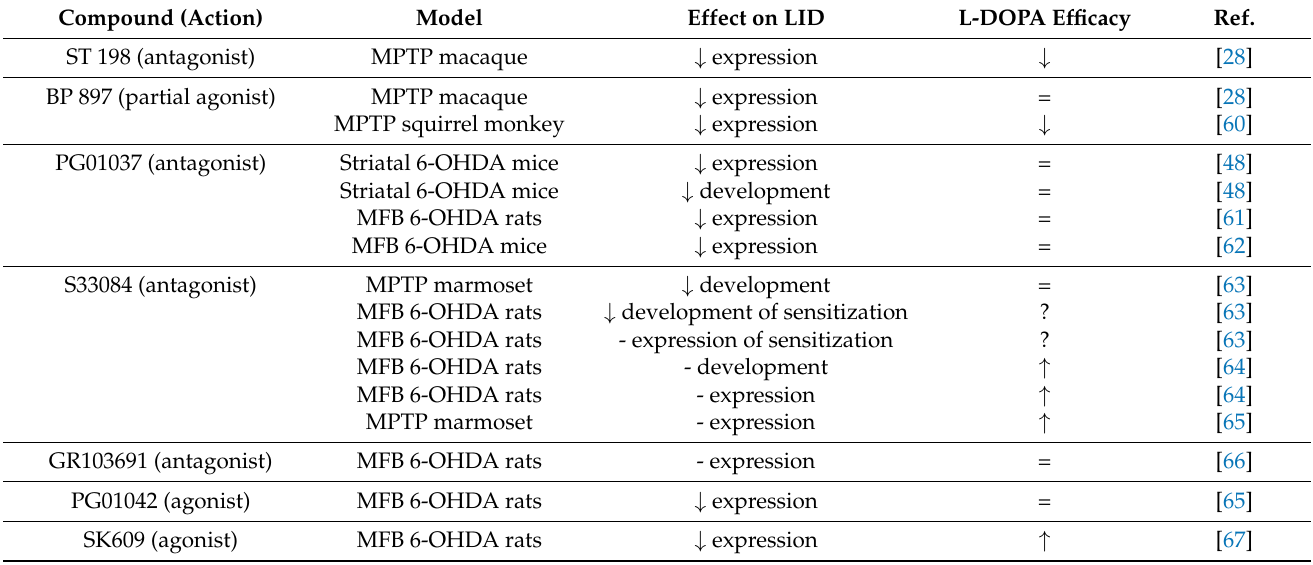
Table 1. Pharmacologic strategies to target